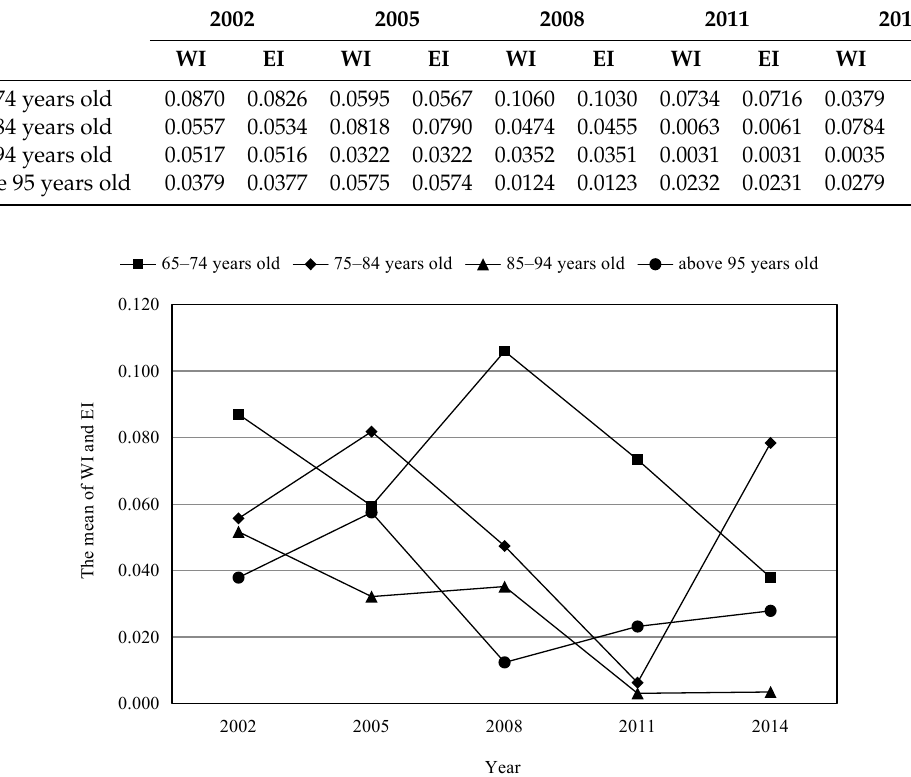
Figure 2. The mean of Wagstaff index (WI) and Erreygers index (EI) of the elderly in different age groups from 2002 to 2014.